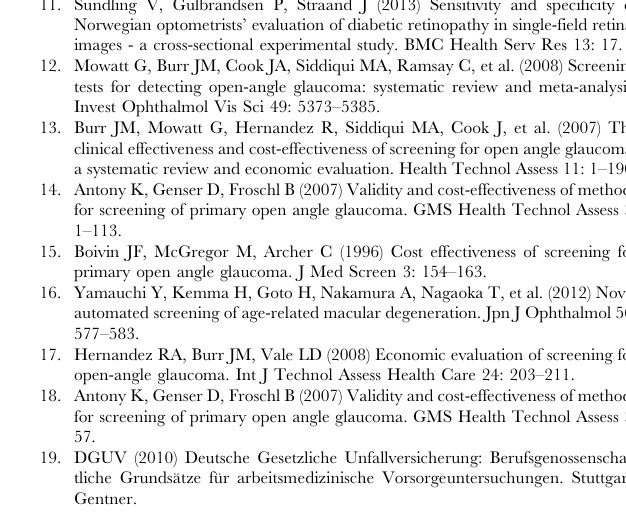
Table S1 General medical history of all participants (n= 4183). Table S2 General examination of all participants (n=